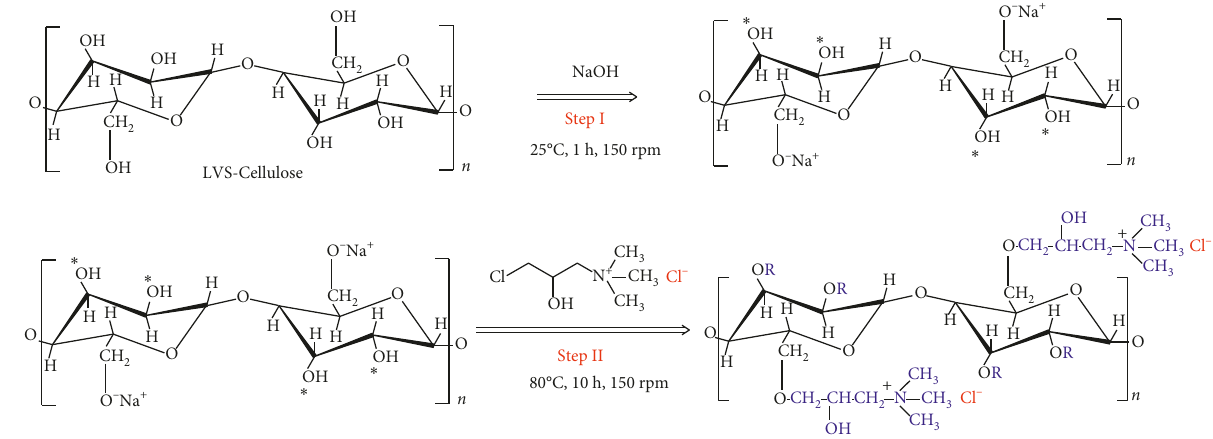
Figure 2: Reaction synthesis pathway of cationic CALV biosorbent.